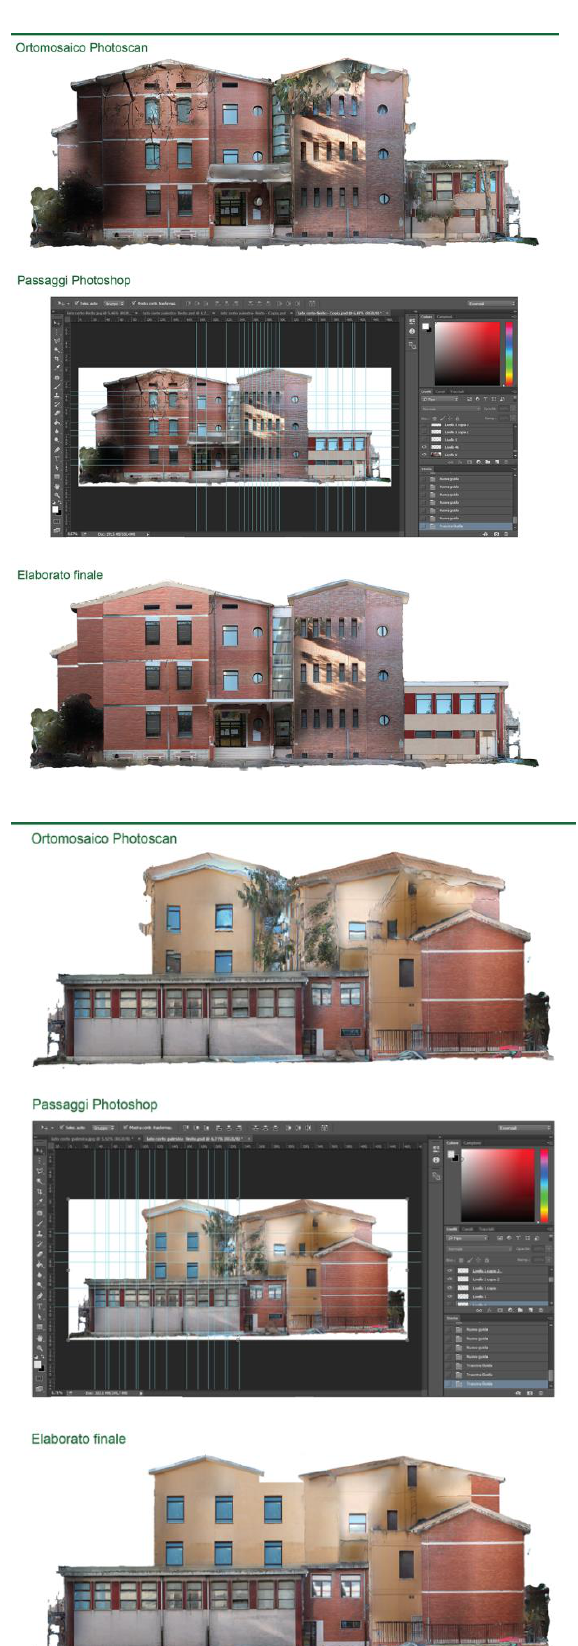
Figure 11. Phases of cleaning and graphic integration of photoplane from photomodelling.